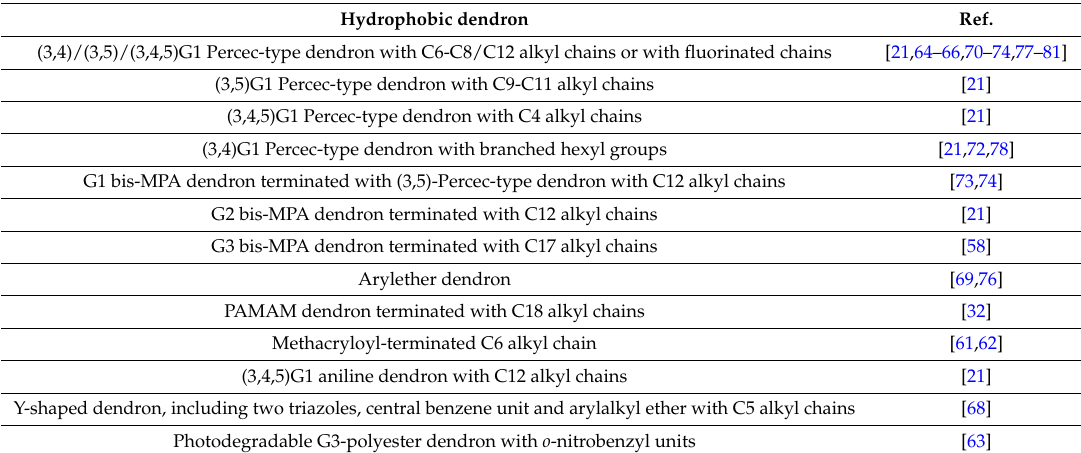
Table 3. Structural features of JDs self-assembling in aqueous environment: hydrophobic dendrons. Hydrophobic dendron Ref.